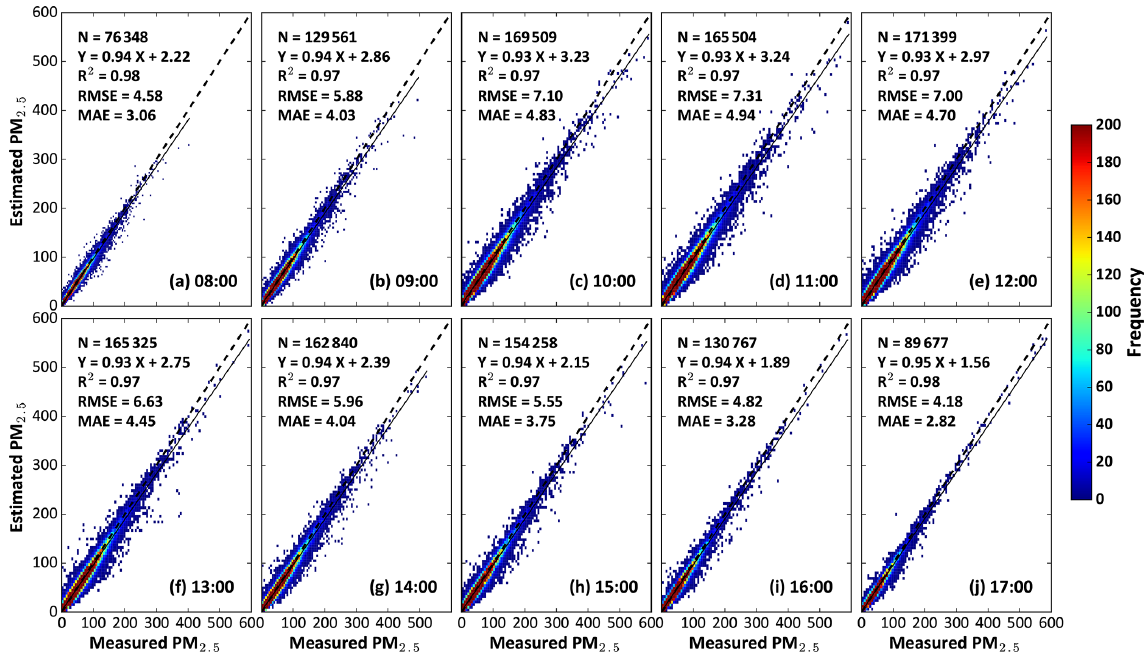
Figure 3. Density scatterplots of model-fitted PM 2 . 5 estimates (µgm − 3 ) at (a) 08:00LT, (b) 09:00LT, (c) 10:00LT, (d) 11:00LT, (e) 12:00LT, (f) 13:00LT, (g) 14:00LT, (h) 15:00LT, (i) 16:00LT, and (j) 17:00LT in 2018 in China. Dashed lines denote 1 : 1 lines, and solid lines denote best-fit lines from linear regression.